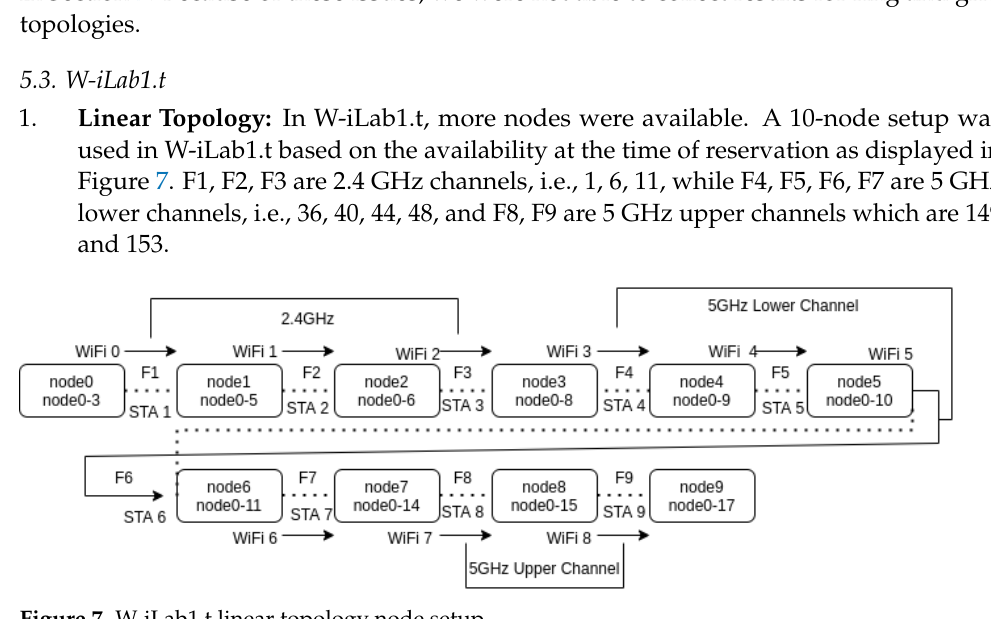
Figure 7. W-iLab1.t linear topology node setup.